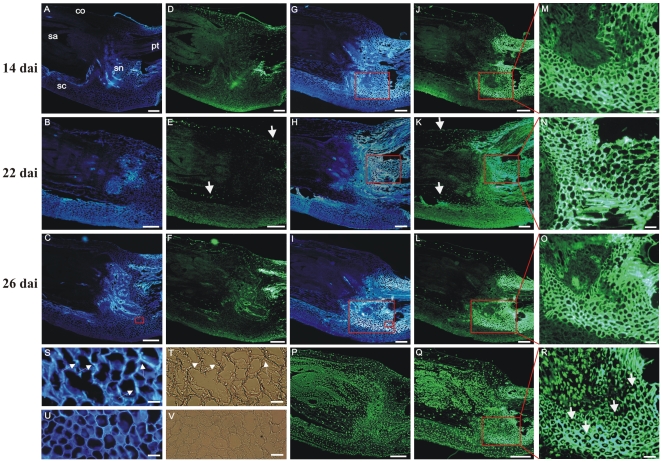
Histological analyses of NIL3876-Rdg2a barley embryos.(A) to (C) Sections of embryos grown under control conditions observed under UV excitation. (D) to (F) Sections in (A) to (C) subjected to TUNEL analysis. (G) to (I) Sections of embryos inoculated with leaf stripe isolate Dg2 and observed under UV excitation. (J) to (L) Sections in (G) to (I) subjected to TUNEL analysis; the bright green fluorescence at the level of scutellar node and provascular tissue is due to cell wall autofluorescence. (M) to (O) Magnified views of the boxed regions in (J) to (L) and (G) to (I). (S) and (T) Magnified views of the smaller box in (I) stained with calcofluor (S) or observed under bright field (T); arrows indicate the intercellularly growing P. graminea mycelium. (U) and (V) Magnified views of the small box in (C) stained with calcofluor (U) or observed under bright field (V). (P) and (Q) Respectively, sections of control and inoculated embryos at 26 dai, treated with DNase I and subjected to TUNEL analysis. (R) A magnified view of the region boxed in (Q). White arrows in Figure 7E, K and R indicate TUNEL positive nuclei. Scale bars represent 200 µM (A) to (L), 50 µM (M) to (O) and 25 µM (S) to (T). co  =  coleoptile, pt  =  provascular tissue, sa  =  shoot apex, sn  =  scutellar node.